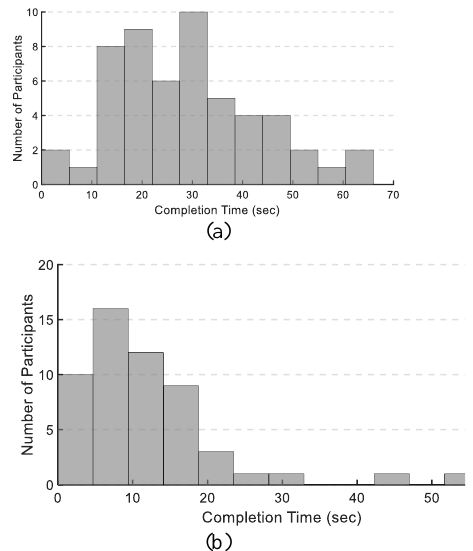
Figure 6. Distribution of completion times of map based approach (a) and AR based approach